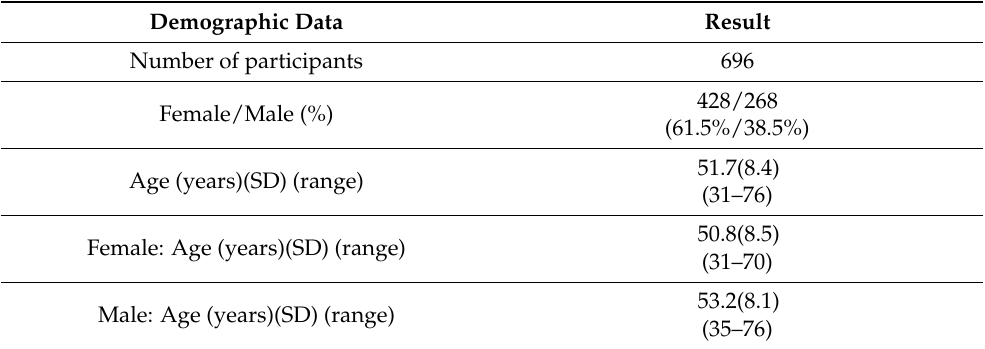
Table 3. Number of participants by federal state (in alphabetical order) in absolute values and in percent (%).